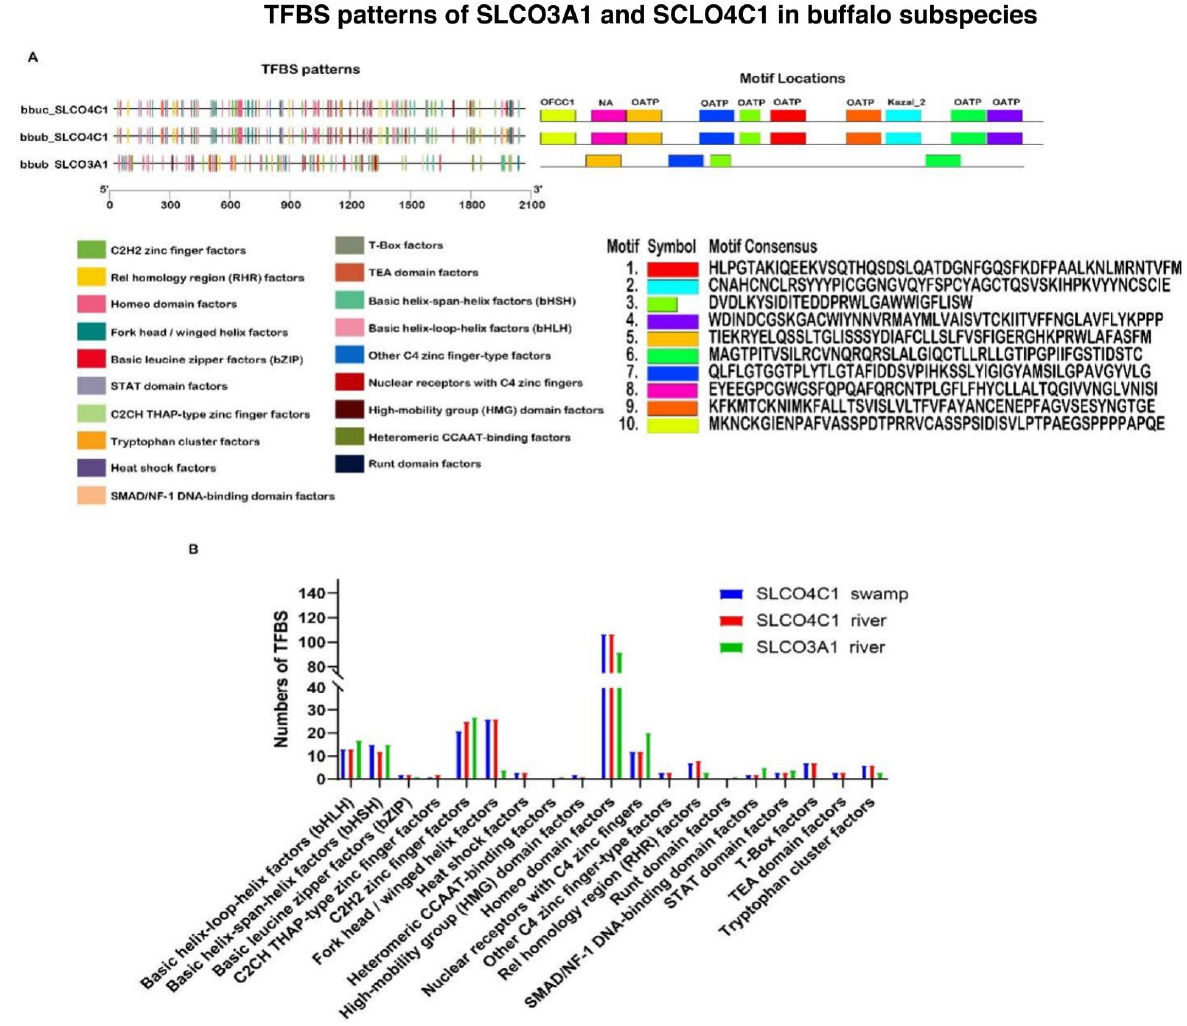
Figure 3. The gene structure and TFBS patterns of SLCO3A1 and SCLO4C1 in buffalo subspecies. ( A ) The TFBS and motif patterns of SLCO3A1 and SCLO4C1 between the two subspecies. ( B ) The number of TFBS of SLCO3A1 and SCLO4C1 between the two subspecies.